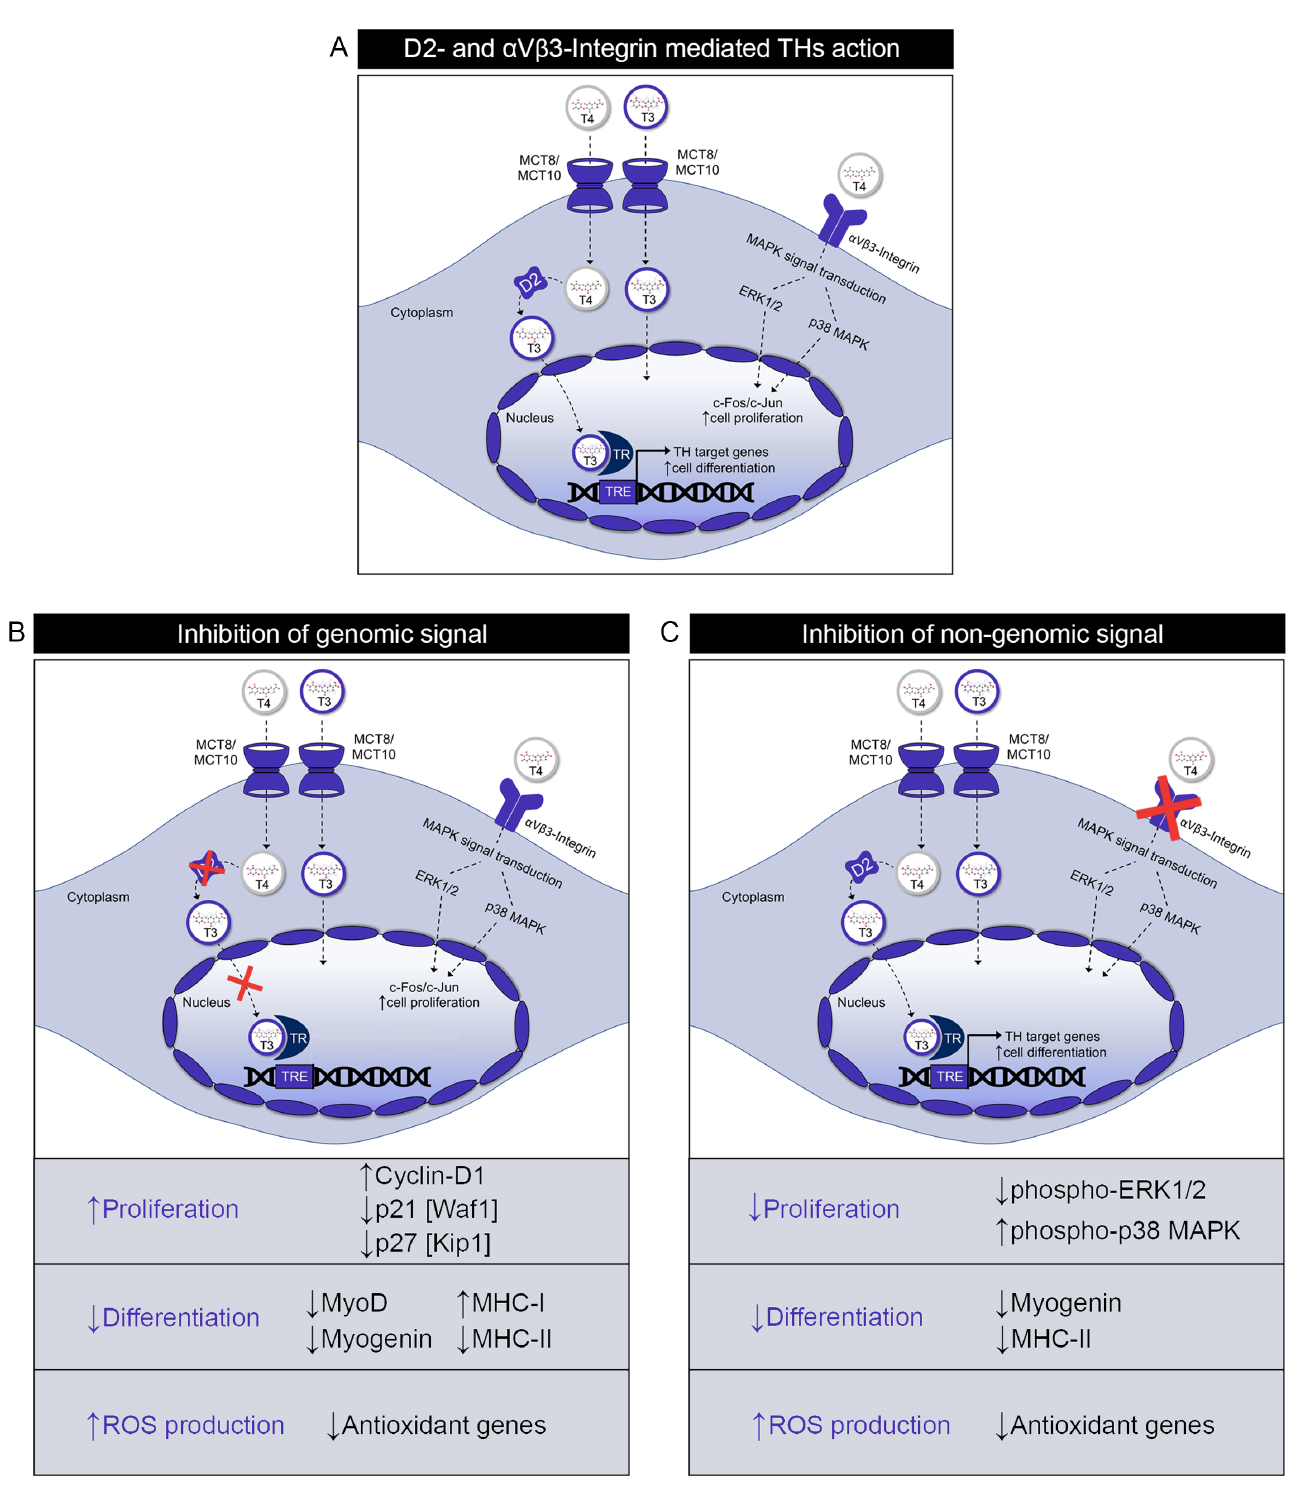
Figure 5. Thyroid hormones act via both genomic and non-genomic mechanisms to regulate muscle physiology. ( A ) Schematic representation of D2-mediated TH activation and α V β 3-Integrin dependent action of THs. ( B ) Conse- quences of inhibition of D2 expression and the relative reduction of TH activation in D2 KO muscle cells. ( C ) Effects of inhibition of α V β 3-Integrin expression in muscle cells. The purple arrows indicate the up-regulation and the down- regulation of the processes influenced by D2 KO and β 3-Integrin KO, while the black arrows were used to specify the involved